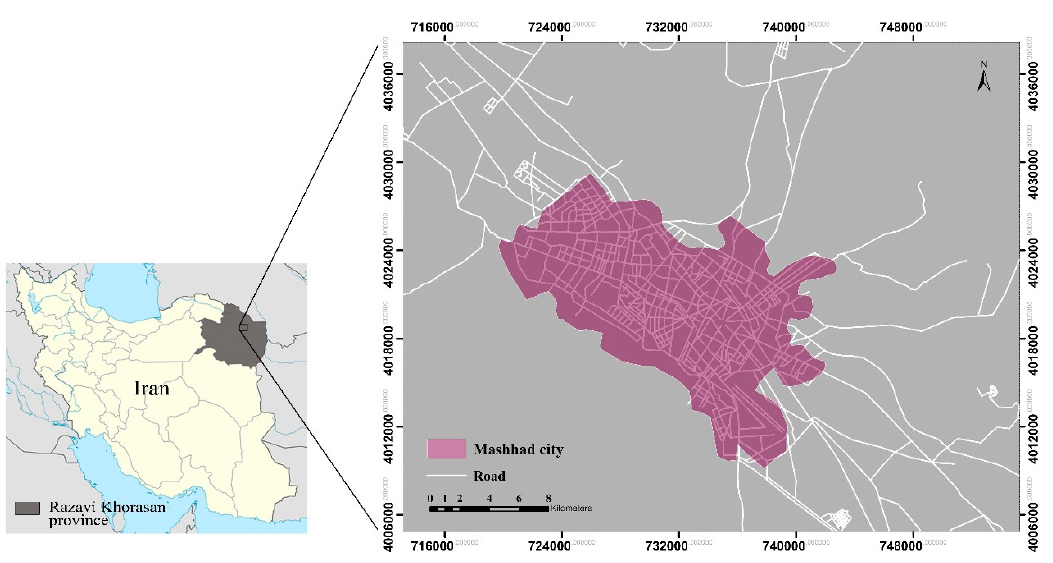
Figure 1. Location map of the study area.